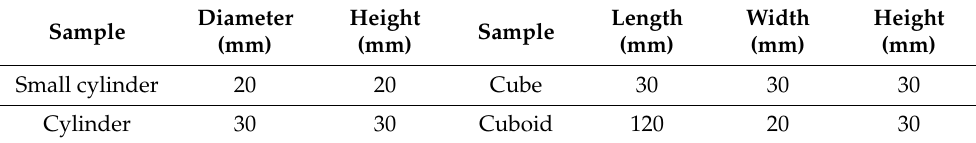
Figure 1. Used samples. Table 1. Sample dimensions.